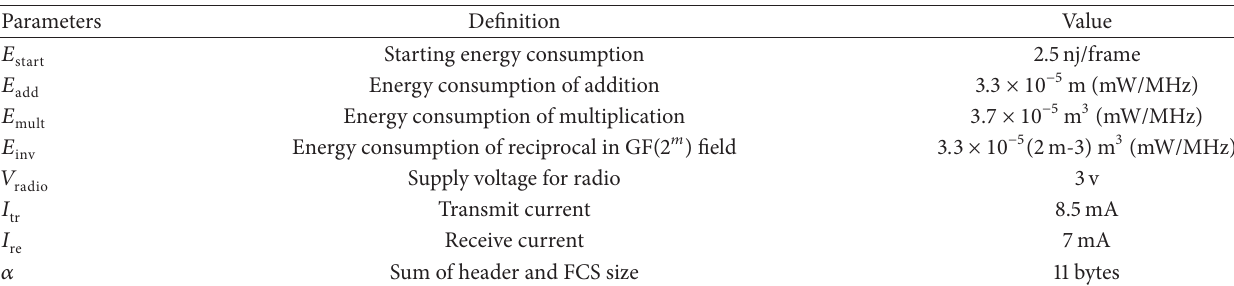
Table 1: Definitions and value of parameters in (9) and